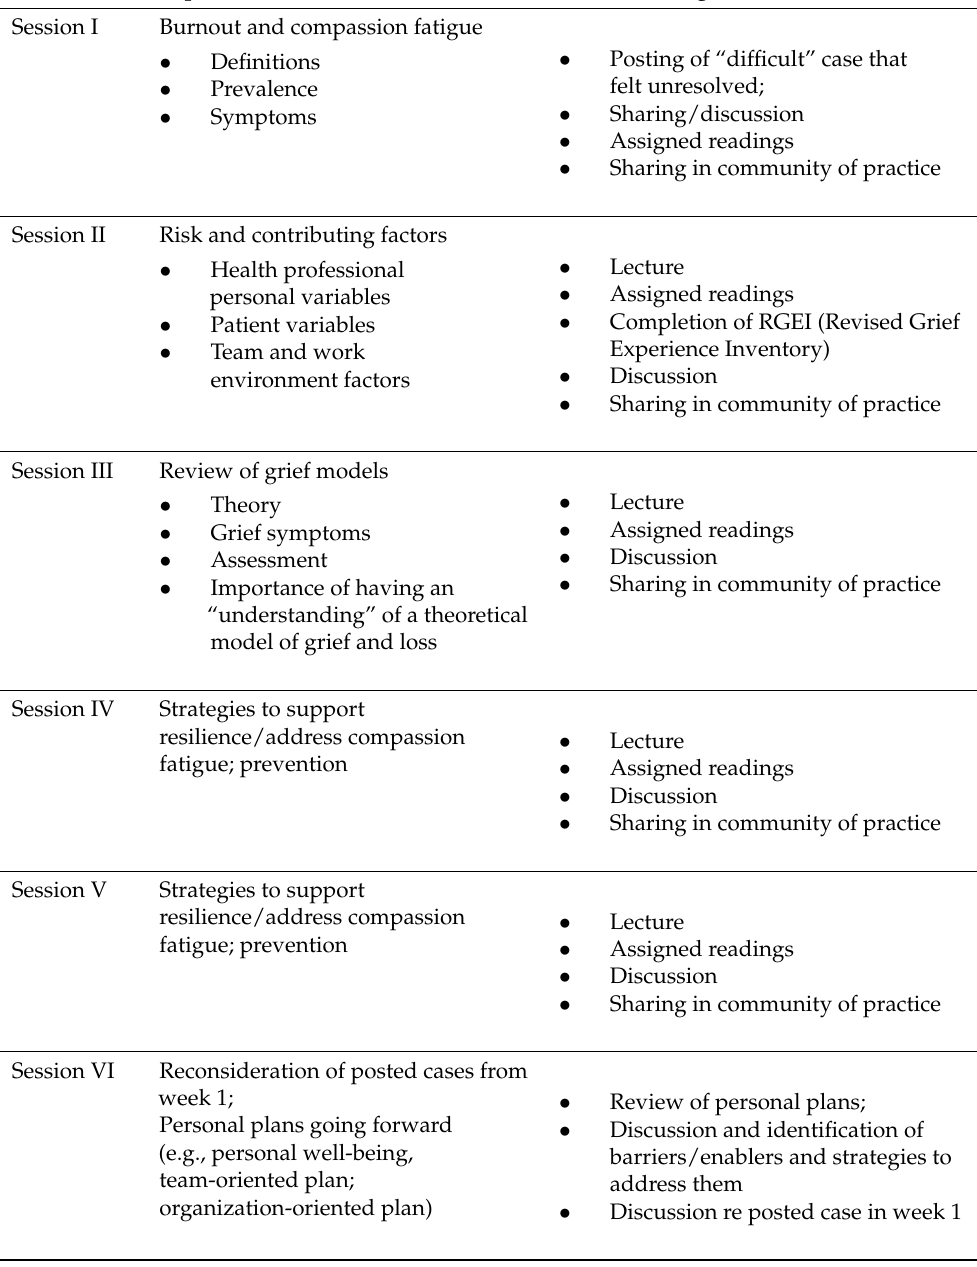
Table 1. Description of the educational